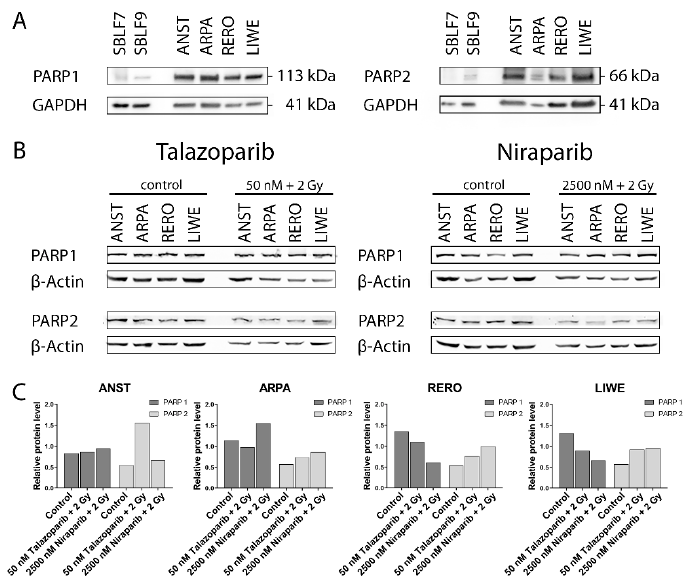
Figure 1. Western blot analyses of the PARP1 and PARP2 content. Levels of PARP1 and PARP2 in Western blot of ( A ) untreated healthy skin fibroblast and melanoma cell cultures and ( B ) melanoma cell cultures 48 h after the treatment with PARPi (50 nM Talazoparib respectively 2500 nM Niraparib) plus 2 Gy IR compared to untreated control groups. ( C ) Quantification of the PARP1 and PARP2 protein content after the combined treatment.